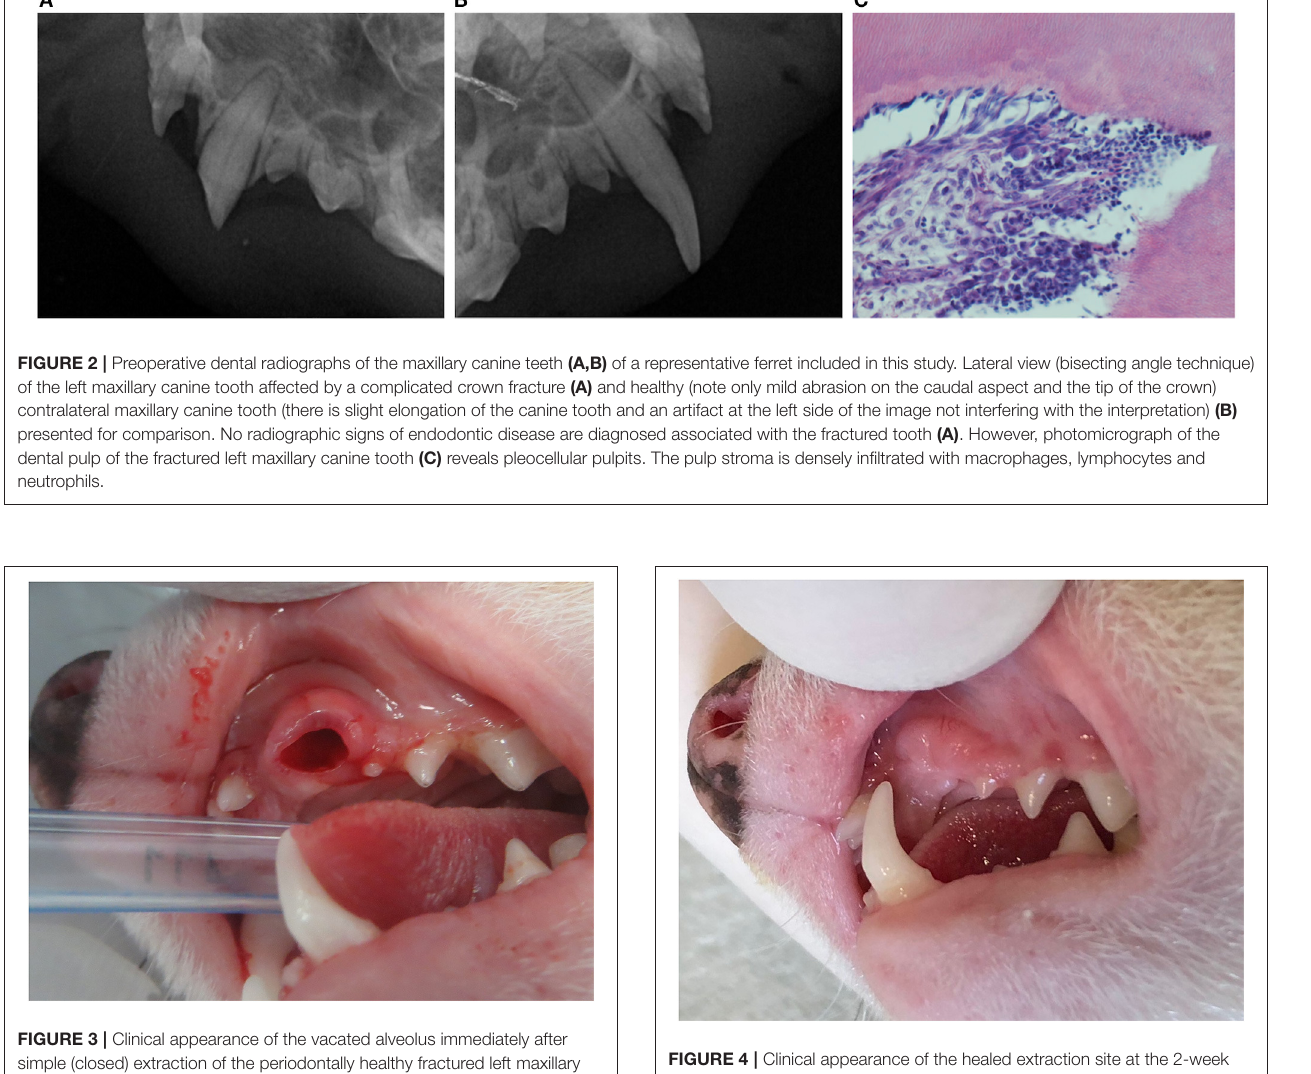
FIGURE 4 | Clinical appearance of the healed extraction site at the 2-week recheck examination of the non-sedated